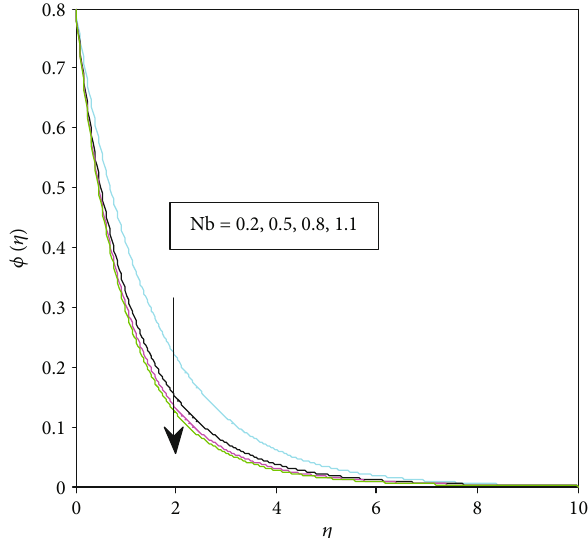
Figure 27: Concentration distribution for di ff erent values of Brownian di ff